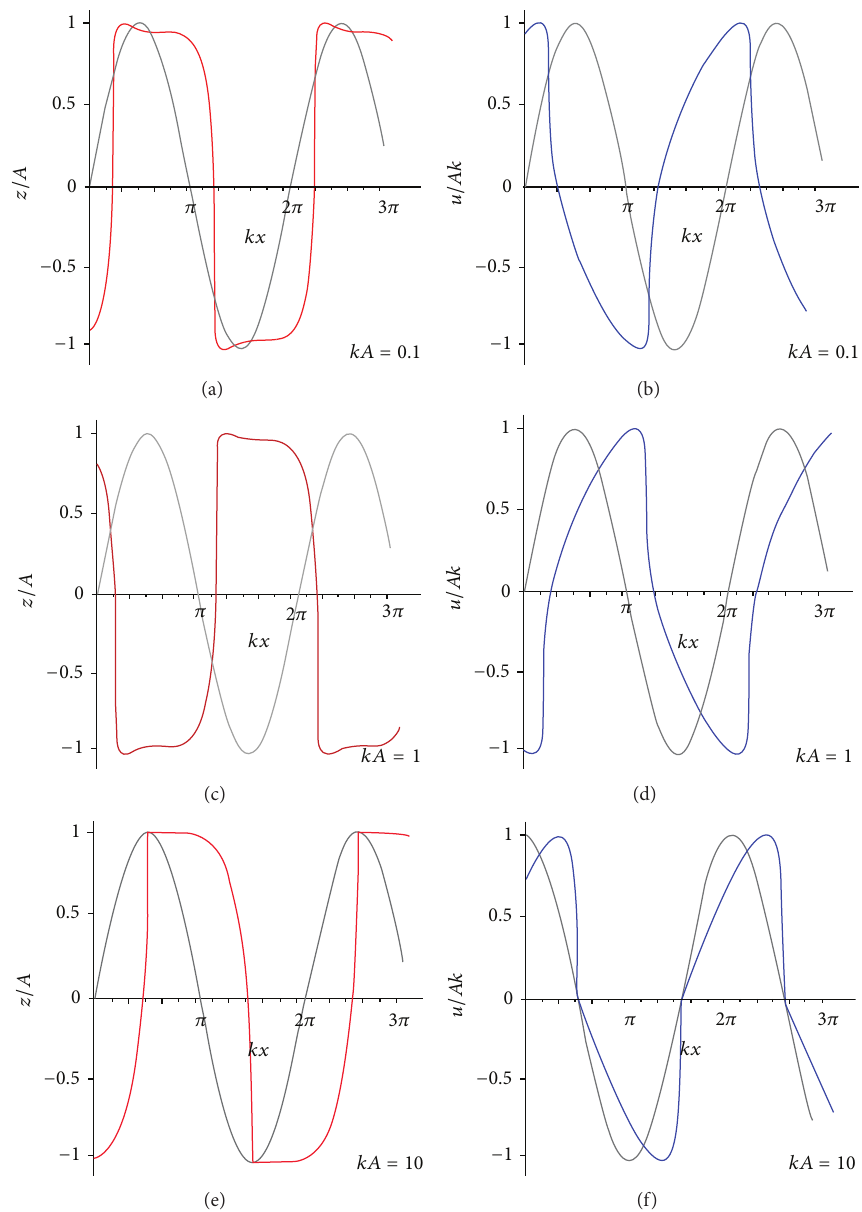
= 200.5 and 𝑘𝐴 = 0.1 ;(c)-(d) 𝑘𝑇 br